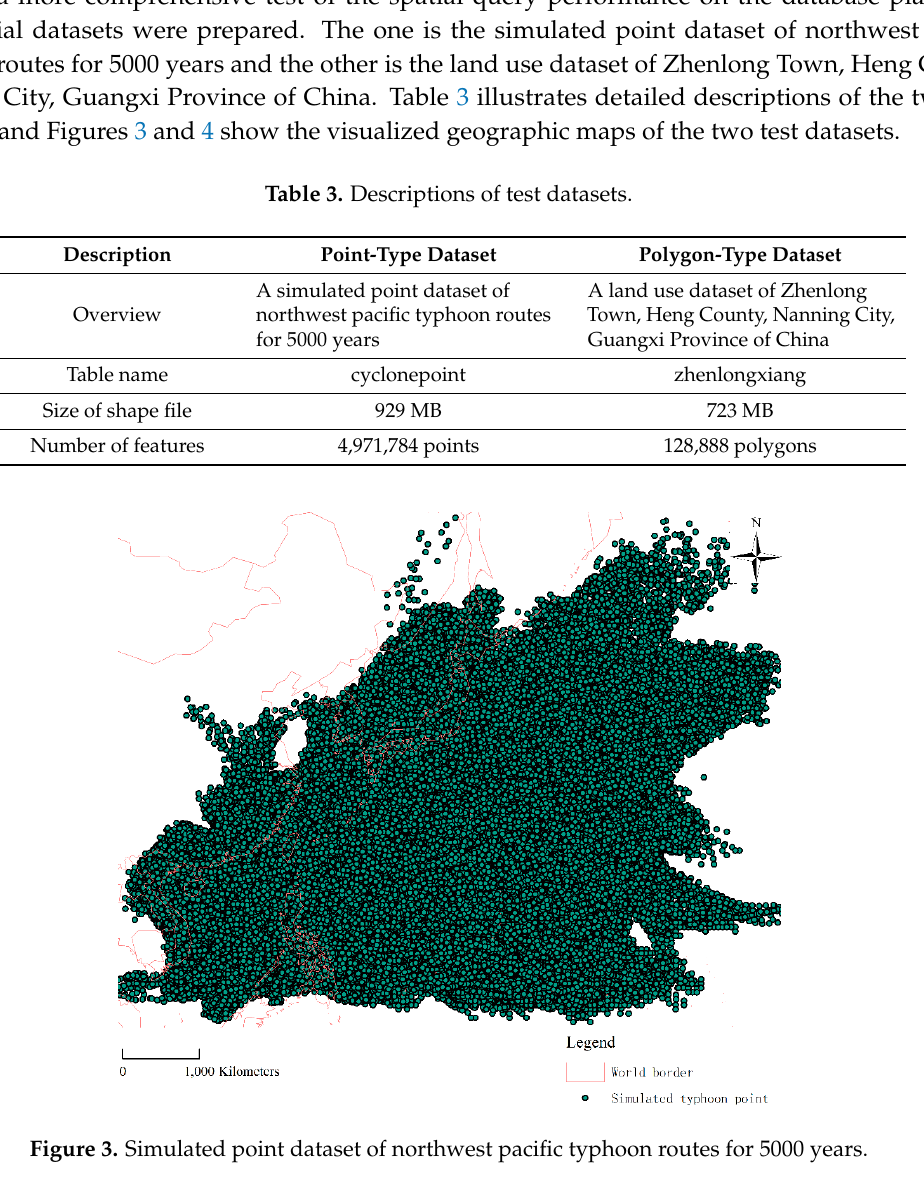
Figure 3. Simulated point dataset of northwest pacific typhoon routes for 5000 years.